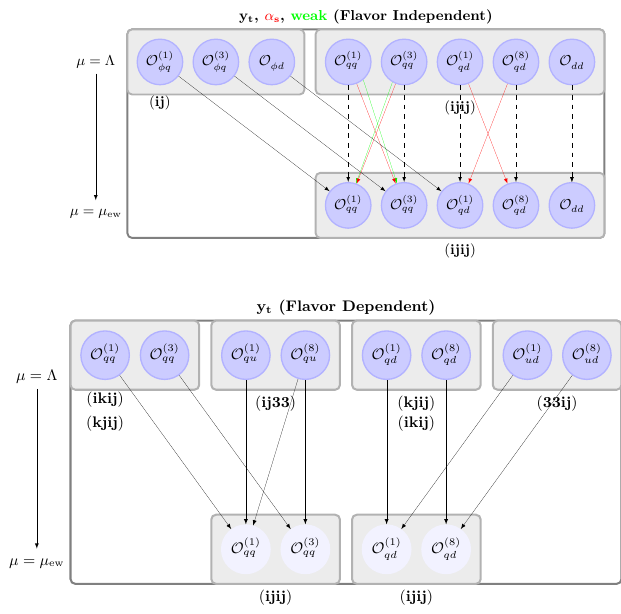
Figure 2 . Mixing of operators relevant for ∆ F = 2 observables for the K 0 − ¯ K 0 and B s,d − ¯ B s,d mixing in the Warsaw down-basis. The red, green and black lines indicate the mixing due to strong, electroweak and top-Yukawa couplings, respectively. The self-mixing is shown by a dashed black line. Here k = 1 , 2 , 3 . For the up-basis the mixing due to top-Yukawa, i.e. all black lines